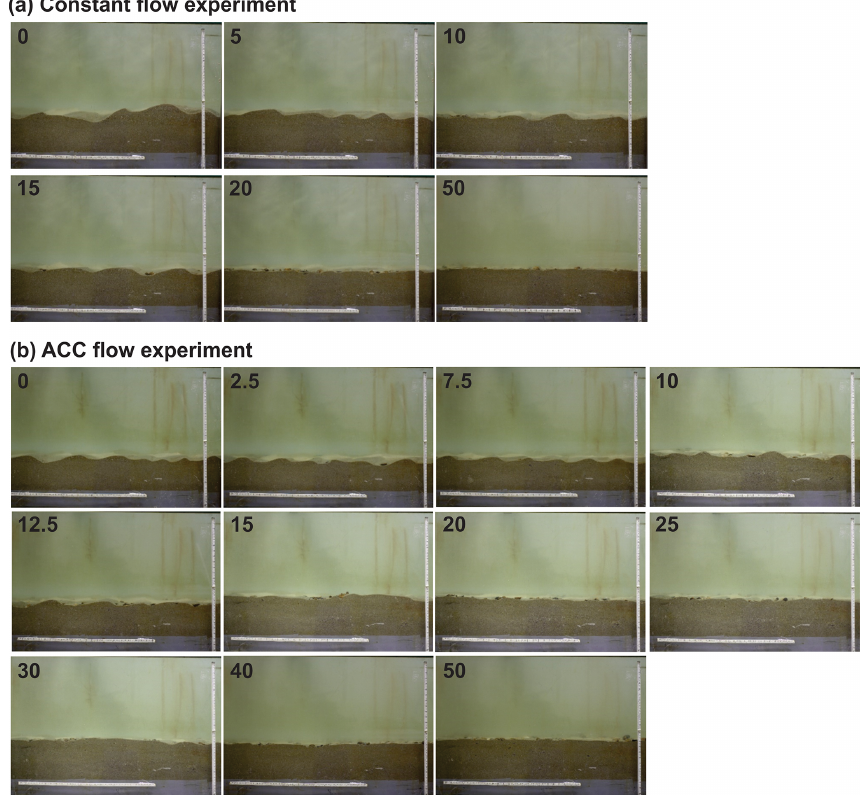
Figure 2. The final frame from each (a) constant flow and (b) ACC flow experimental run. Numbers represent the shell percentage. The white vertical and horizontal rulers are both 50cm in length.